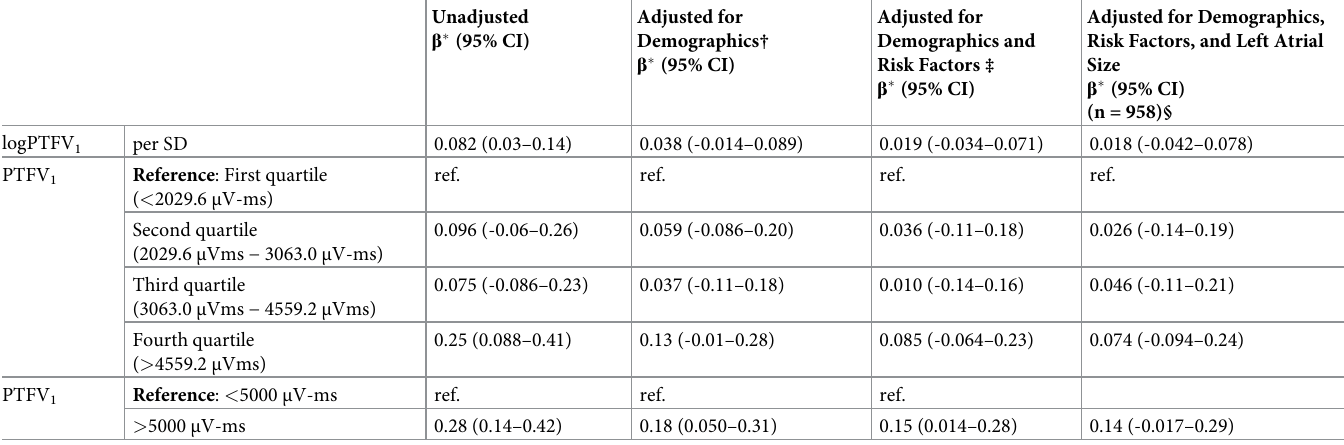
Table 3. Association of P-wave terminal force in lead V 1 (PTFV 1 ) with white matter hyperintensity volume (n =